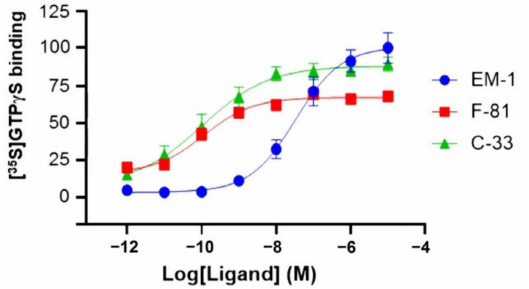
Figure 2. [ 35 S]GTP γ S functional assay in CHO-hMOP cell membranes. Stimulation of [ 35 S]-GTP γ S binding to the human MOP by EM-1, C-33, and F-81. Data are normalized to the maximum stimula- tion caused by EM-2 (100%); values are expressed as mean ± SEM, n =